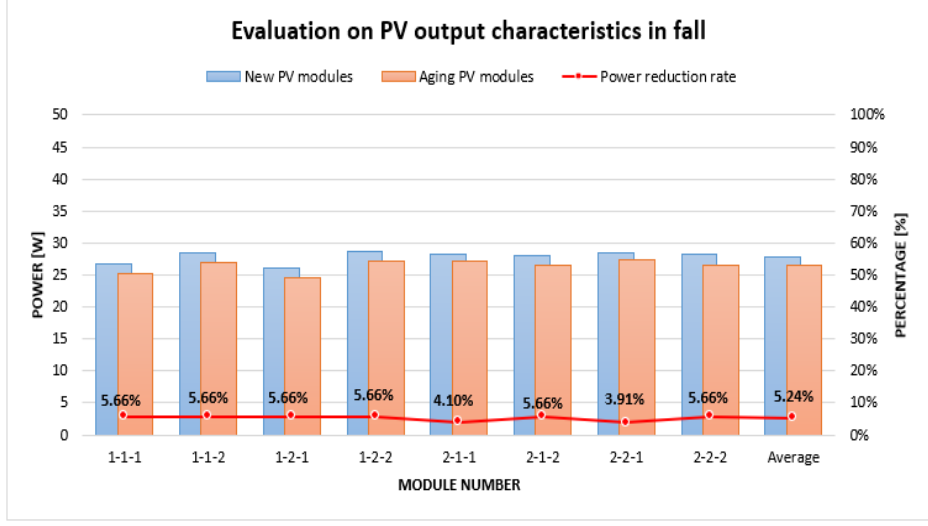
Figure 9. Output characteristics between new and aged PV modules in fall.